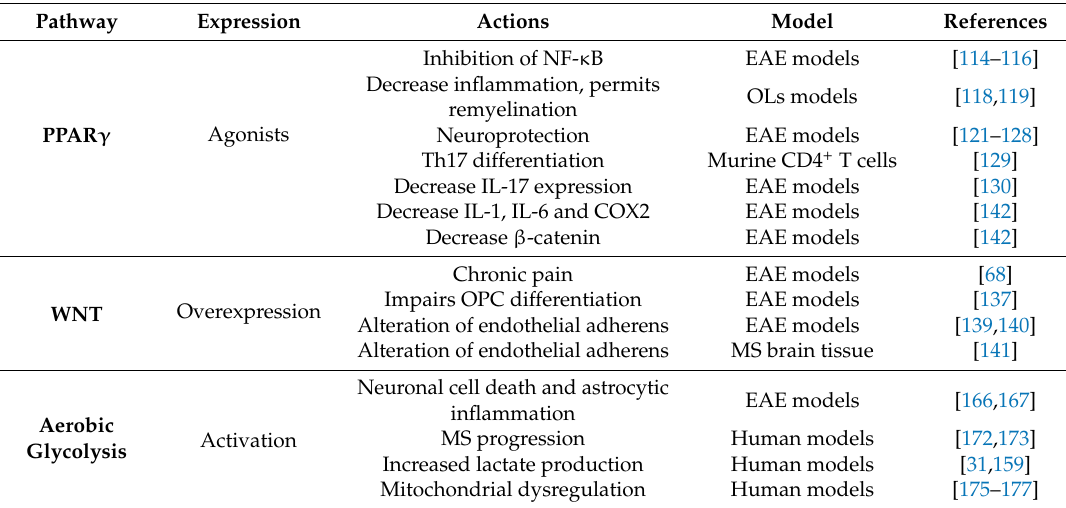
Table 1. WNT pathway, peroxisome proliferator-activated receptor γ (PPAR γ ) and aerobic glycolysis in multiple sclerosis (MS)